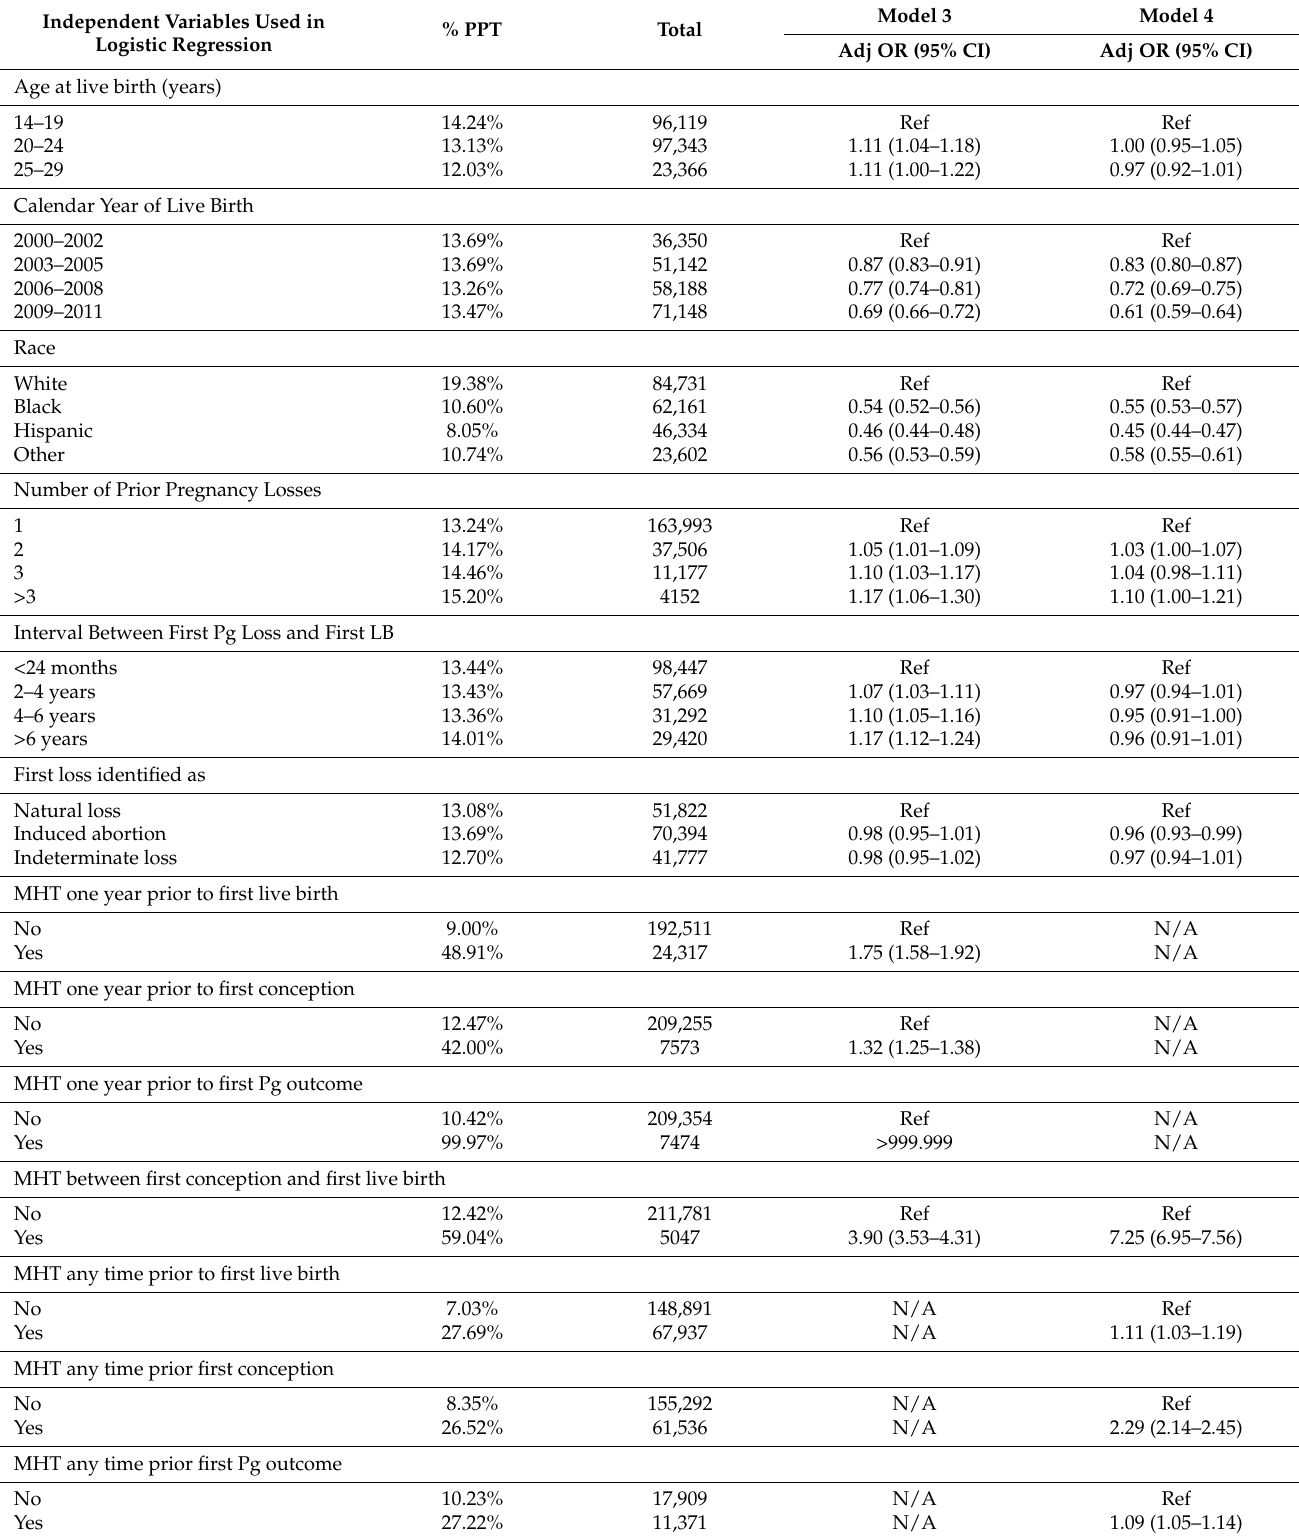
Table 4. PPT risk regression models for women with a history of pregnancy loss ( n = 216,828), controlling for age, race, year of live birth (LB), number of losses, type of first loss, pregnancy interval, and history of